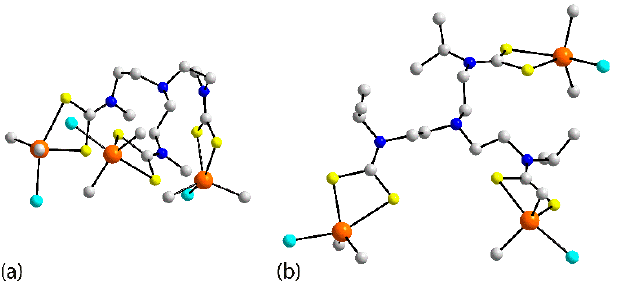
Figure 18. Molecular structures of ( a ) (Me 2 SnCl) 3 (L 38 ) in the crystal of 91 and ( b ) (Me 2 SnCl) 3 (L 39 ) in 92 .